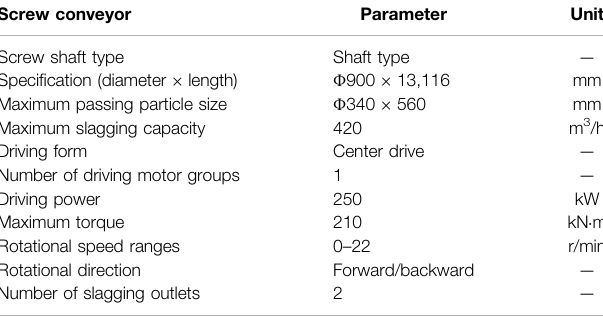
TABLE 1 | Screw conveyor parameters.